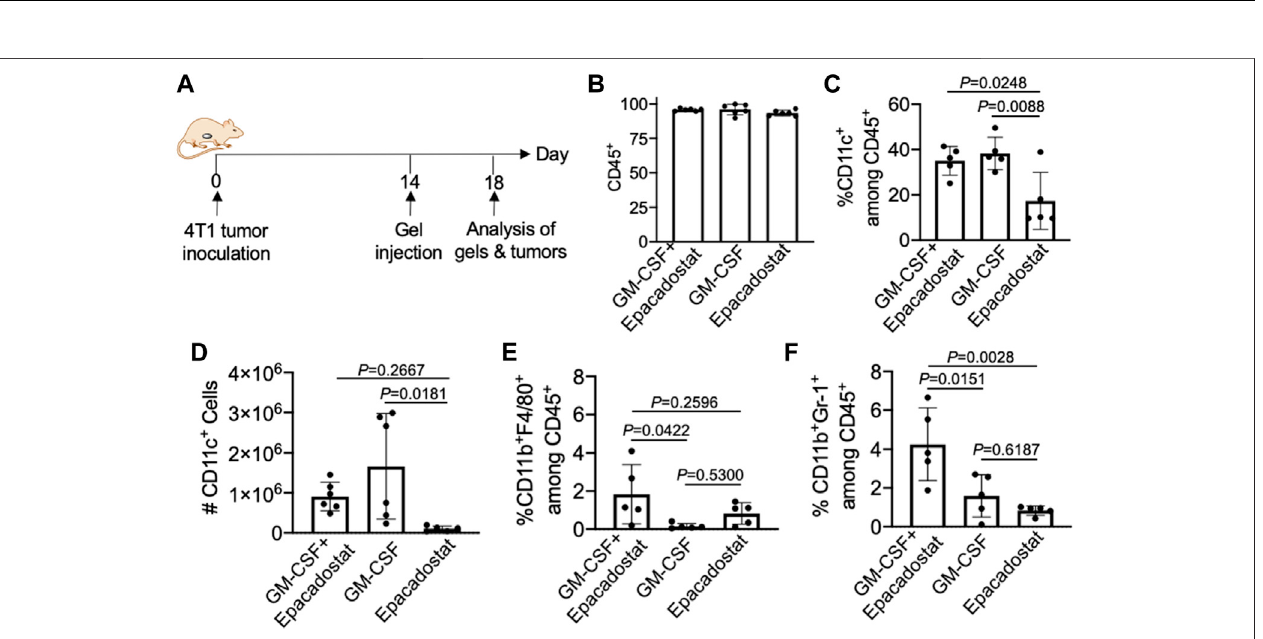
Frontiers in Pharmacology |